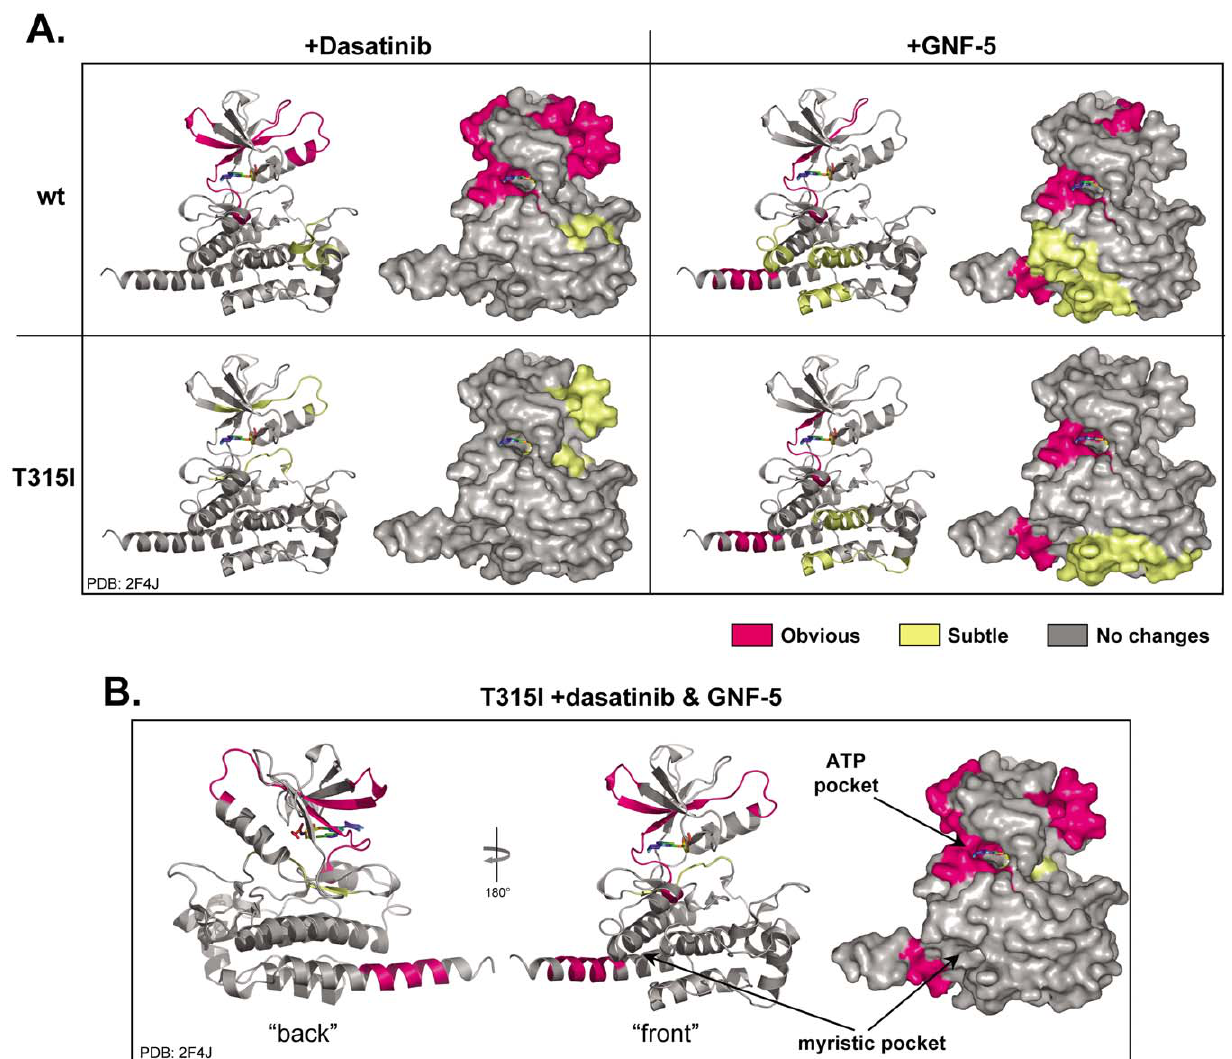
Figure 3. Summary of the hydrogen exchange results for all binding experiments in this study. In each panel, the ribbon diagram of Abl (PDB 2F4J, [46]) is shown in the left and the space filling model is shown on the right. The differences in deuterium levels are colored on each peptide